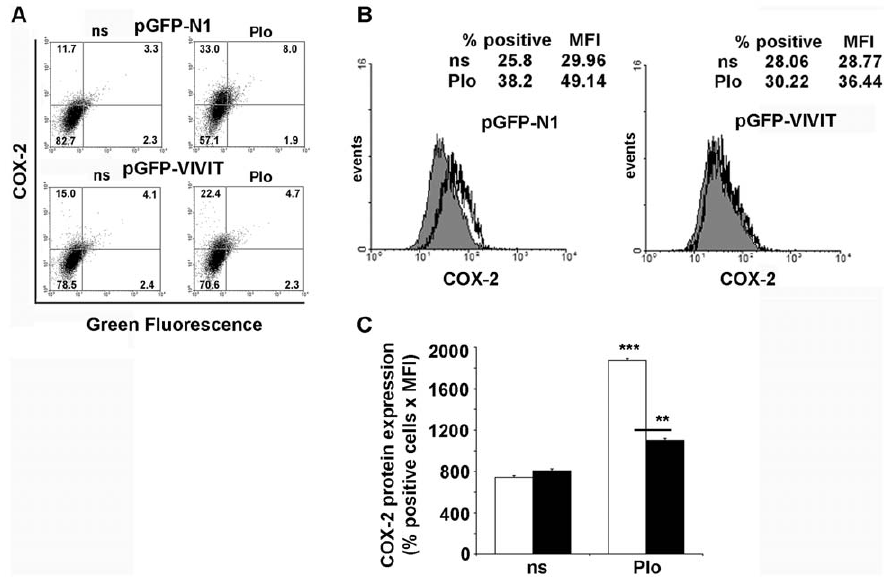
Figure 5. Inhibition of endogenous CN-NFAT binding with the exogenously expressed VIVIT peptide blocked COX-2 protein expression. (A and B) Primary stromal cells isolated from uteri of non-pregnant rats were transfected with 800 ng of expression constructs encoding either pEGFP-VIVIT or pEGFP-N1 as control. Transfected cells were stimulated for 14 h with PIo, or left untreated (ns). Cells were permeabilized and stained for COX-2. Detection of cells co-expressing both COX-2 and GFP protein was analyzed by two color-FACScan. (A) Density plots showing FACScan analysis of transfected cells immunostained for COX-2 protein. The percentage of acquired cells in each quadrant is embedded. (B) Upper panels: Histograms showing COX-2 immunostaining of gated, GFP positive- cells. Left: pGFP-N1- transfected cells; rigth: pGFP-VIVIT- transfected cells. Closed gray histogram: non-stimulated (ns) cells; open black histogram: (PIo)- stimulated cells. The percentage of COX-2-positive cells (% positive) and the mean fluorescence intensity (MFI) from each histogram are enclosed. Lower panel: Bar graphs showing the product of the percentage of COX-2-positive cells and the mean fluorescence intensity, from GFP-positive cells ploted in upper panels. Open bars: cells transfected with pEGFP-N1; dark bars: cells transfected with the pEGFP-VIVIT. (A–B) The results shown are from a representative experiment of three performed, and values are the means 6 SD of duplicate determinations. *** P , 0.001; ** P , 0.01 (ANOVA).